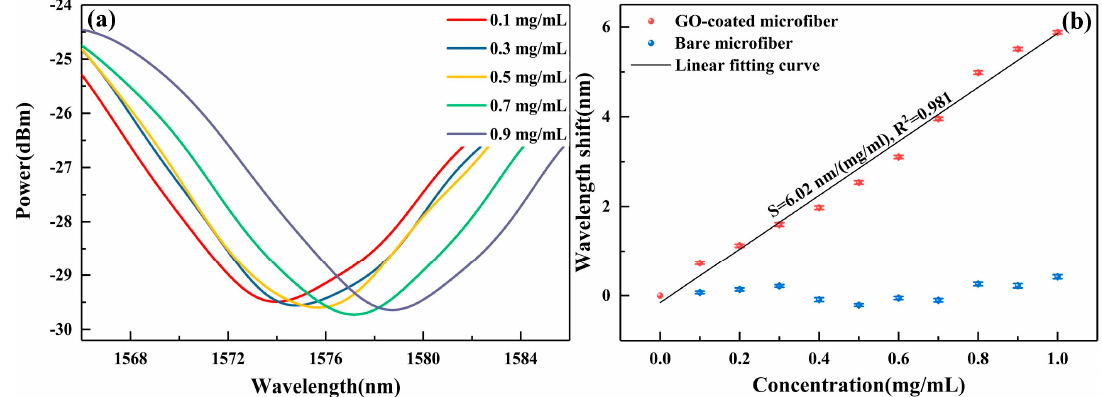
Figure 10. ( a ) Spectra of Hb solutions with di ff erent concentration, ( b ) the corresponding wavelength shift with the Hb concentration.